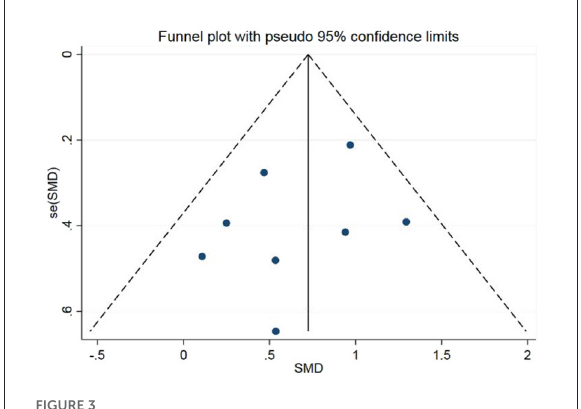
FIGURE3 Funnel plot of meta-analysis on all studies.